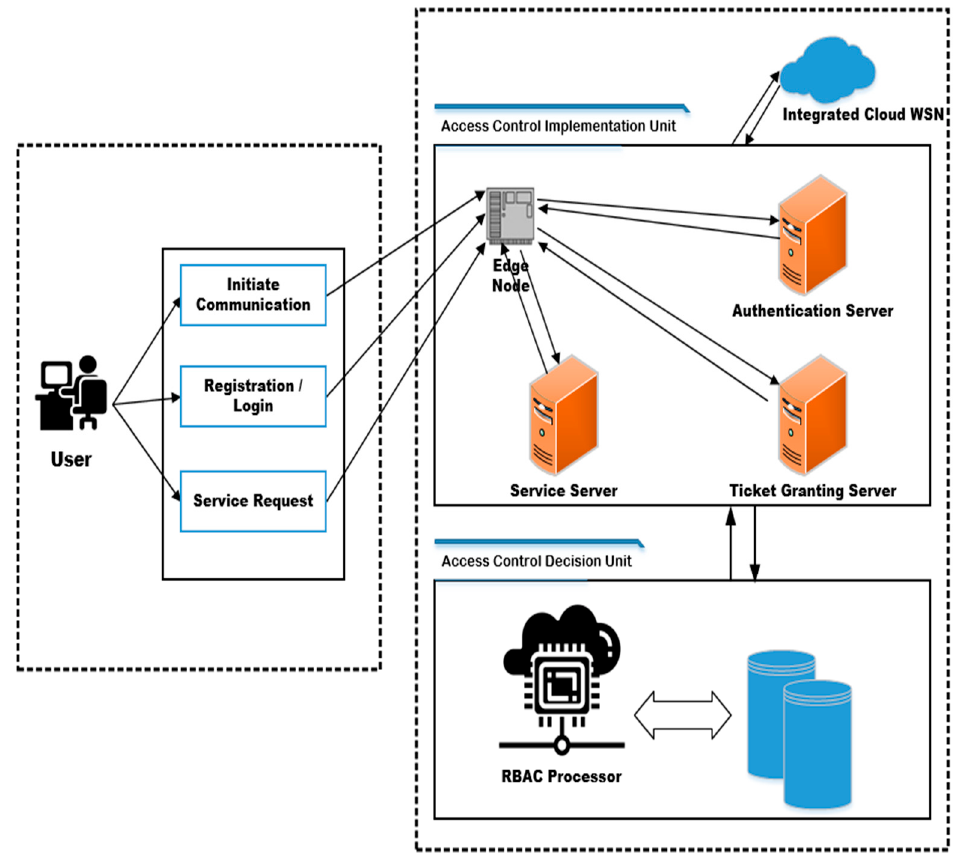
Figure 2. Overall identity and access management unit.